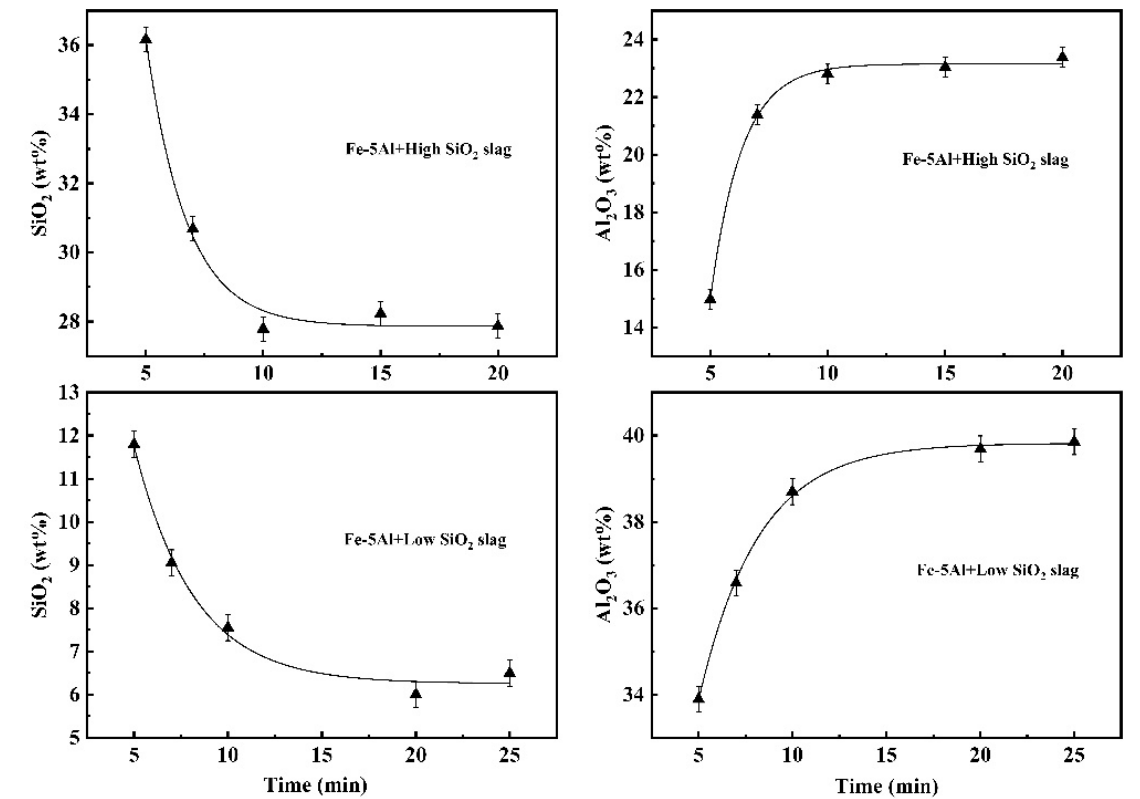
Figure 16. Composition change of mold flux during reaction between Fe-5Al alloy and molten flux.